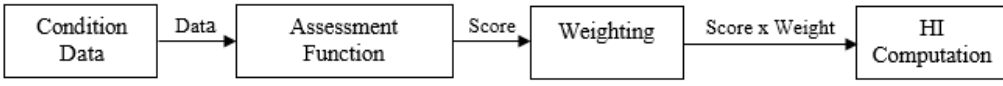
Figure 1. Health Index (HI) scoring method computational principles for single condition monitoring data (adapted from [30]).